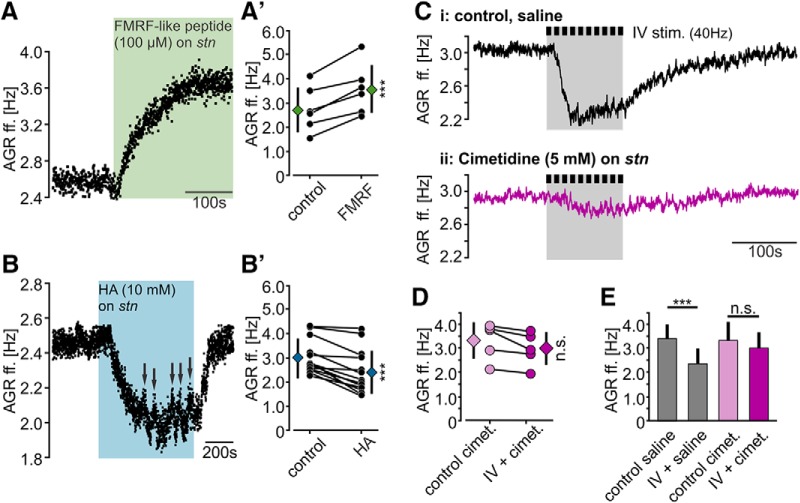
The IV neuron co-transmitter histamine diminishes the AGR ff. mainly via acting on H2 receptors. A, B, AGR ff. in response to (A) FMRF-like peptide F1 and (B) histamine application to the posterior stn. Colored areas mark the time of drug application. Arrows in B indicate switches of AP initiation to other locations. A’, B’, Analysis of the change in AGR ff. before and during application of (A’) FMRF-like peptide F1 and (B’) histamine. Black circles represent individual experiments. Diamonds represent mean ± SD. N = 6 (FMRF-like peptide F1), N = 13 (HA). C, AGR ff. in response to 40 Hz IV neuron stimulation in saline (Ci) and after blocking of H2 receptors with cimetidine (Cii). Recordings are from the same preparation and scaled identically. D, Comparison of AGR ff. during H2 receptor blockade with cimetidine immediately before (control cimet.) and during IV stimulation (IV + cimet.). Circles represent individual experiments. Diamonds represent mean ± SD. n.s. = not significant different, paired t test, t(4) = 2.66; p = 0.056, N = 5 preparations. E, Average change in AGR ff. in saline (gray) and cimetidine (purple). Shown are means ± SD. One-way RM ANOVA, F(4,3) = 33.27, p < 0.001, Holm–Sidak post hoc test with p < 0.05, N = 5 preparations. n.s. = not significant different with p = 0.58.